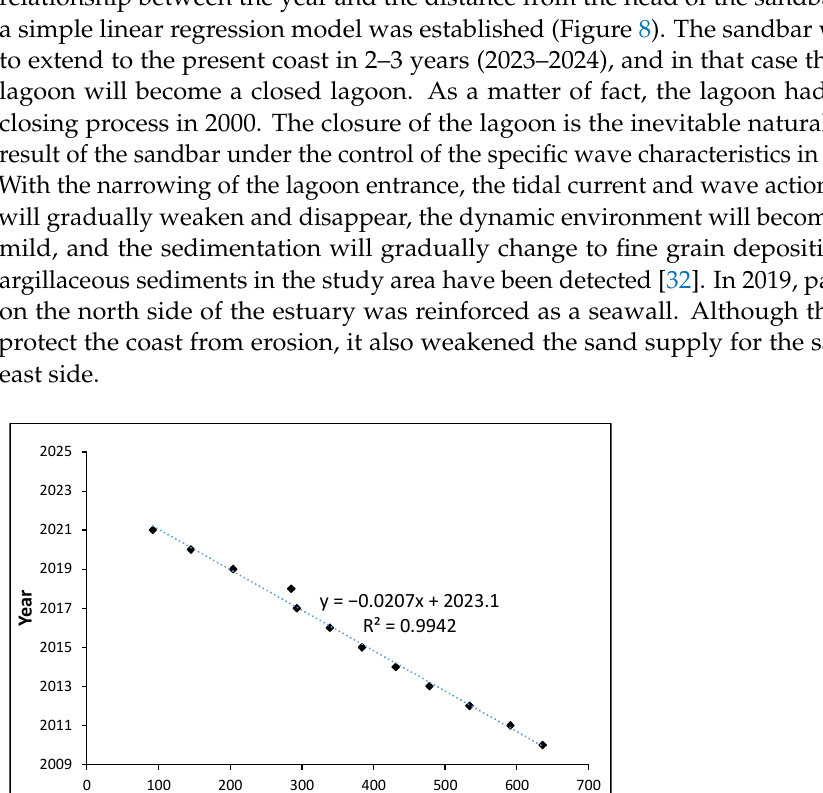
y = −0.0207x + 2023.1 R² = 0.9942